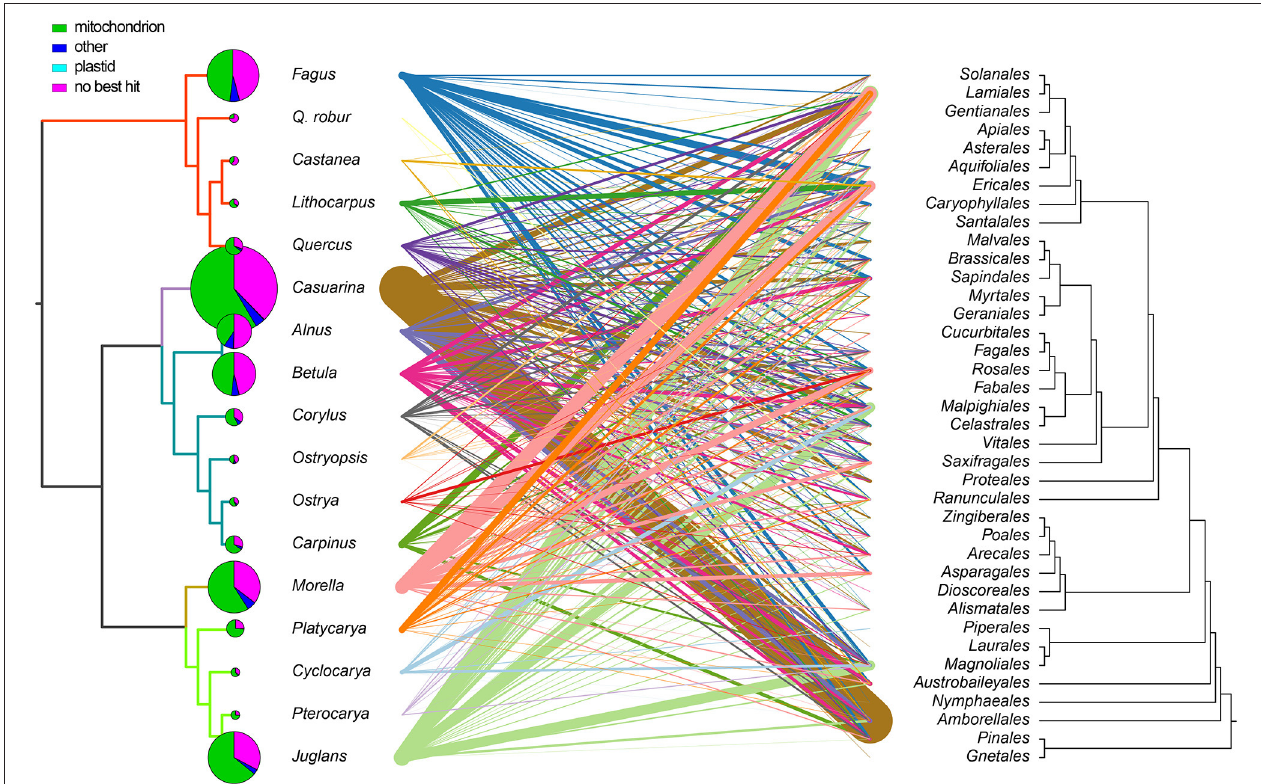
FIGURE 4 | Analysis of mitogenomic GSSs. Best hits of GSSs between Fagales species and their hit taxa (combined into orders) are connected by lines. Each species is represented with a single color, and line thickness indicates the total sequence hit a length. Pie charts indicate the proportions of mitochondrial, plastid, and other hits, and the pie size represents the total GSS length. Details are in Supplementary Tables 4 , 5